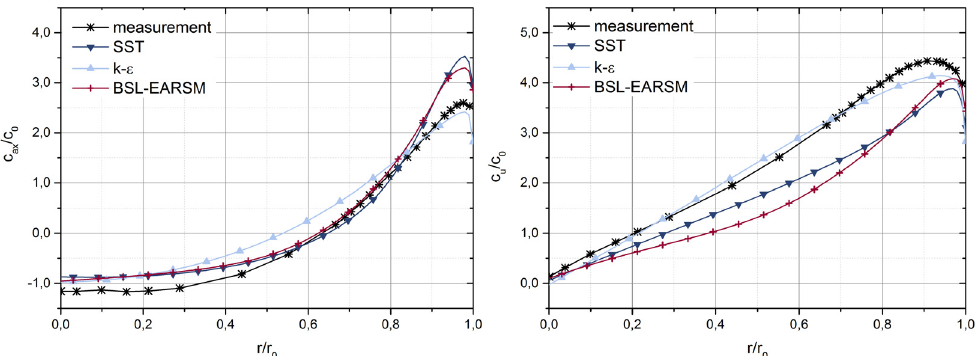
Fig. 6. Comparison of axial ( c ax ) and tangential ( c u ) velocity pro fi les at the lower measurement section (L2) with the experimental velocity pro fi les at the part load, Mossinger [15]; c 0 is the average velocity at the measurement